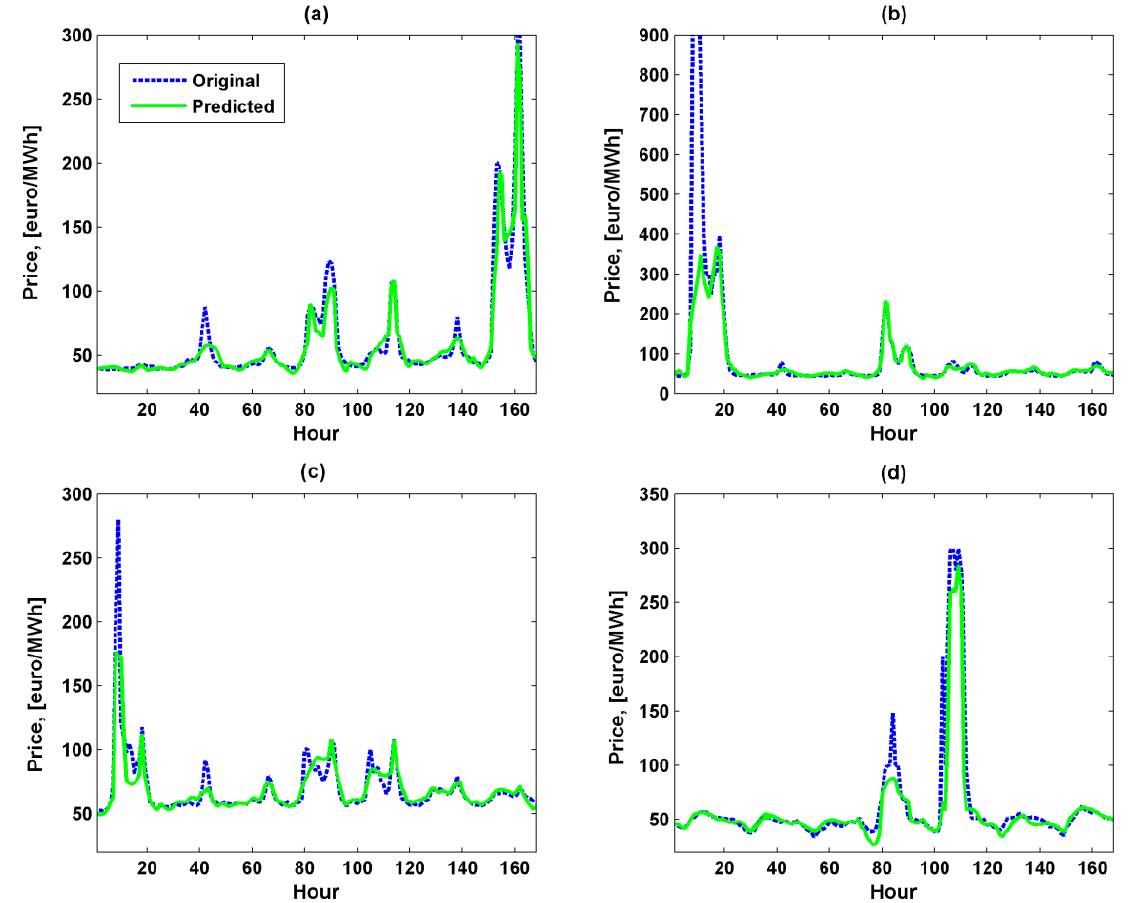
Figure 6. Real and predicted prices for the four weeks with prominent spikes of